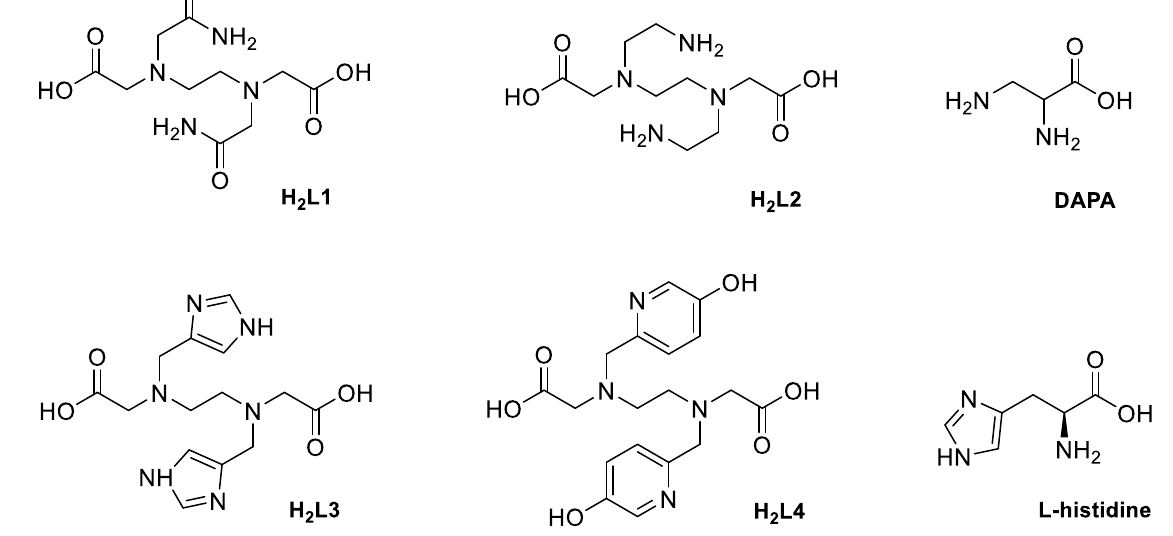
Figure 2. Disubstituted EDTA derivatives and amino acids examined as potential ligands for the development of neutral di-µ-oxo W(V) dinuclear complexes. DAPA: DL-2,3-diaminopropionic acid.